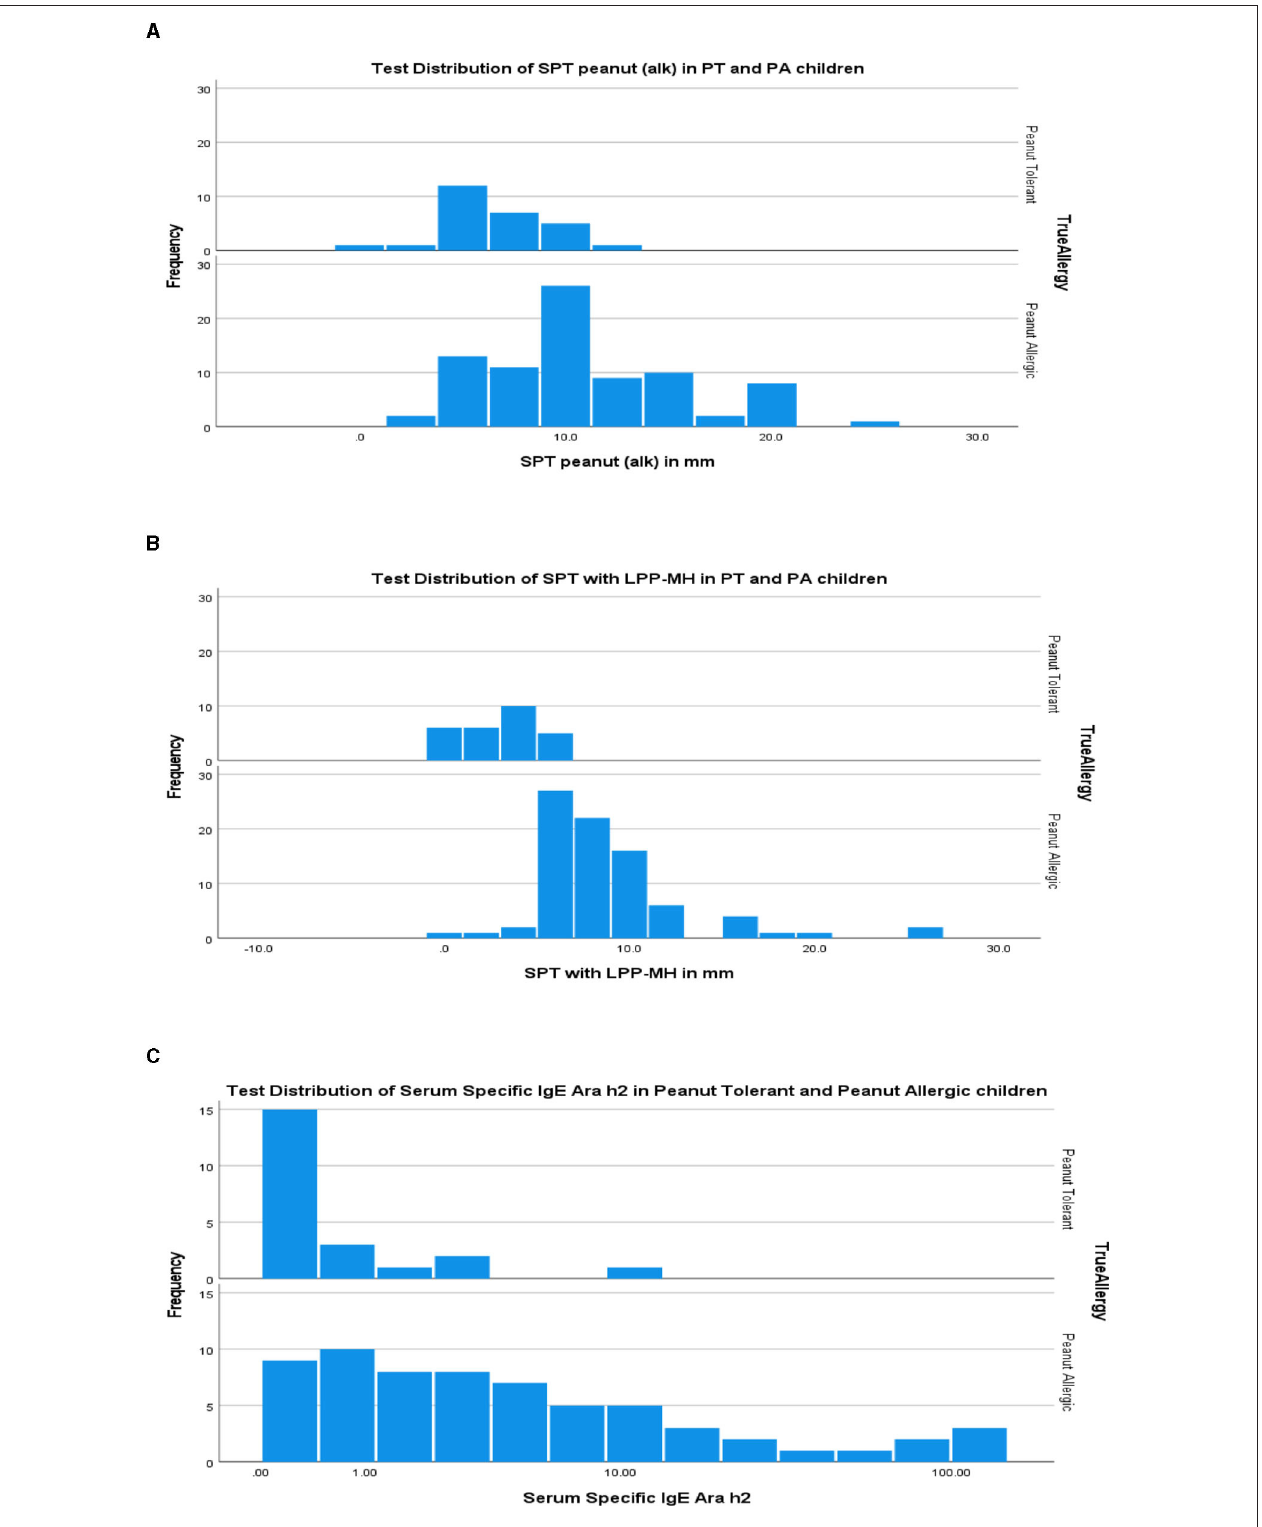
FIGURE 1 | Test distribution of skin tests (A) commercial peanut extract (alk), (B) LPP-MH and (C) Serum Specific IgE to Ara h2 in PT and PA children. PT, Peanut Tolerant, i.e., passed a challenge with 2,000mg of peanut proteins without developing an immediate allergic reaction; PA, Peanut Allergic, i.e., developed an immediate allergic reaction during an observed open challenge with peanut